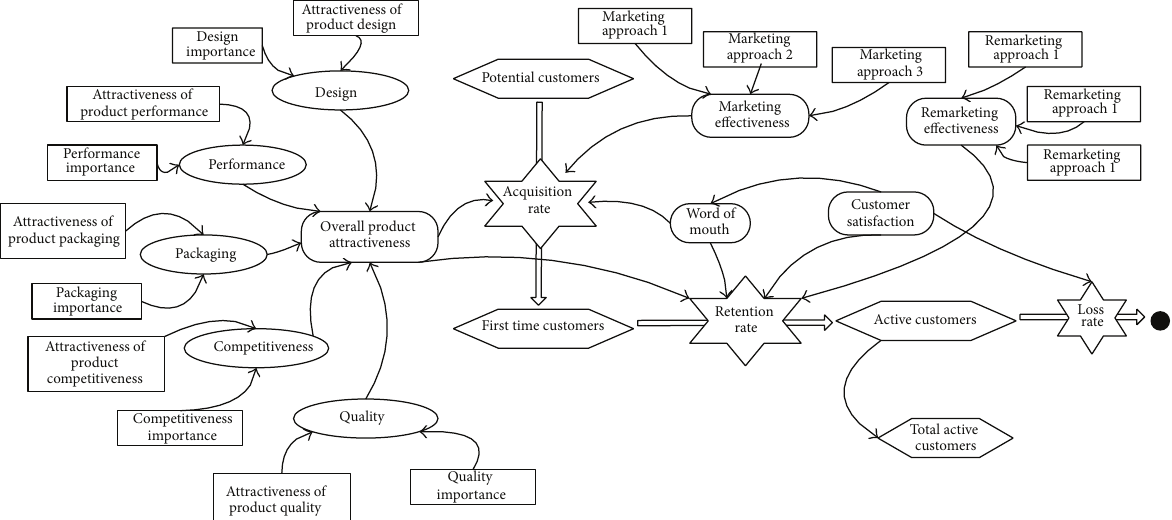
Figure 4: The stimulation figure of customer